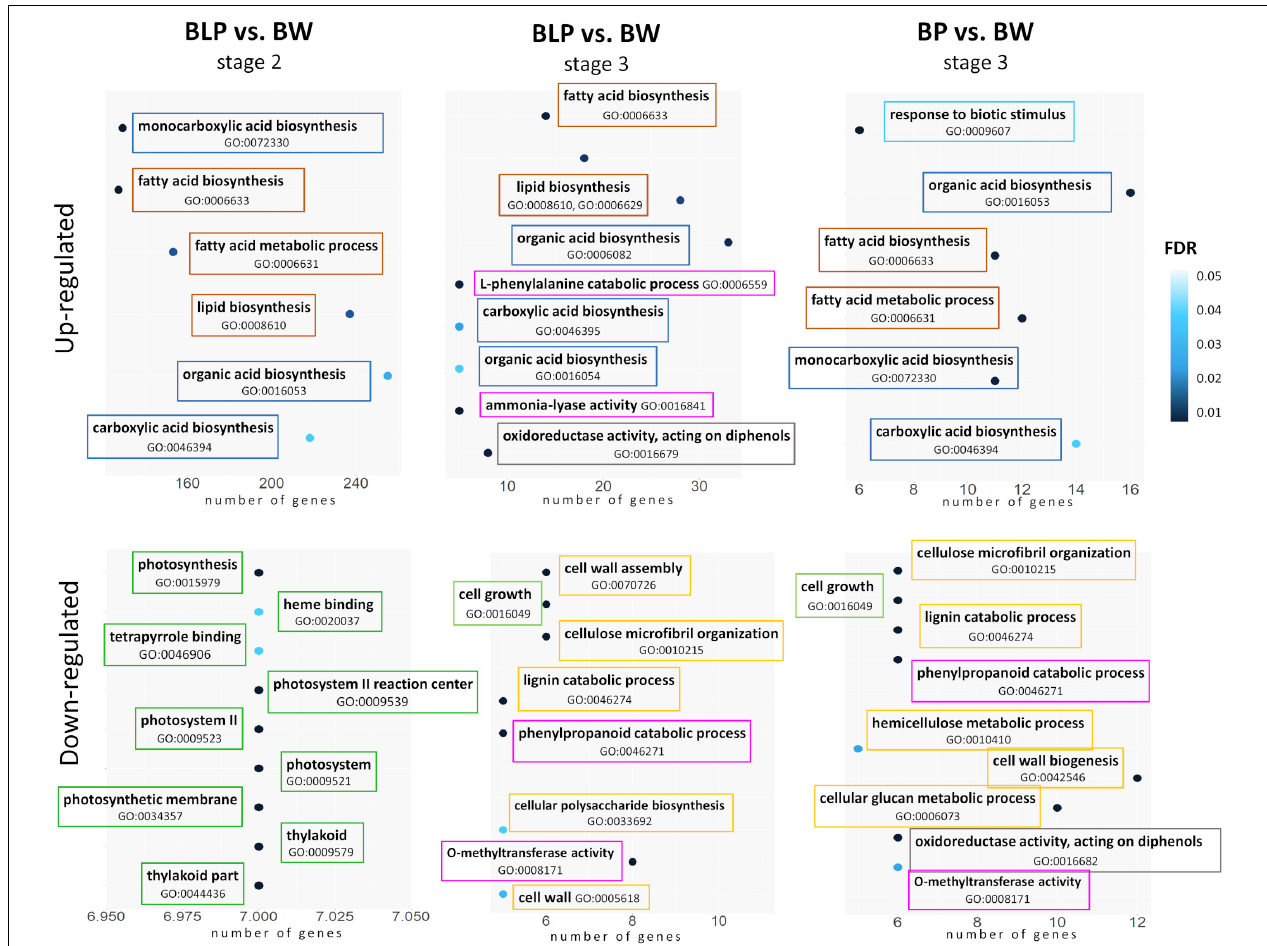
FIGURE 4 | GO term enrichment within lists of upregulated and downregulated DEGs in lines BLP and BP in comparison with Bowman (BW). Related metabolic processes, functions, and compartments are highlighted in the same